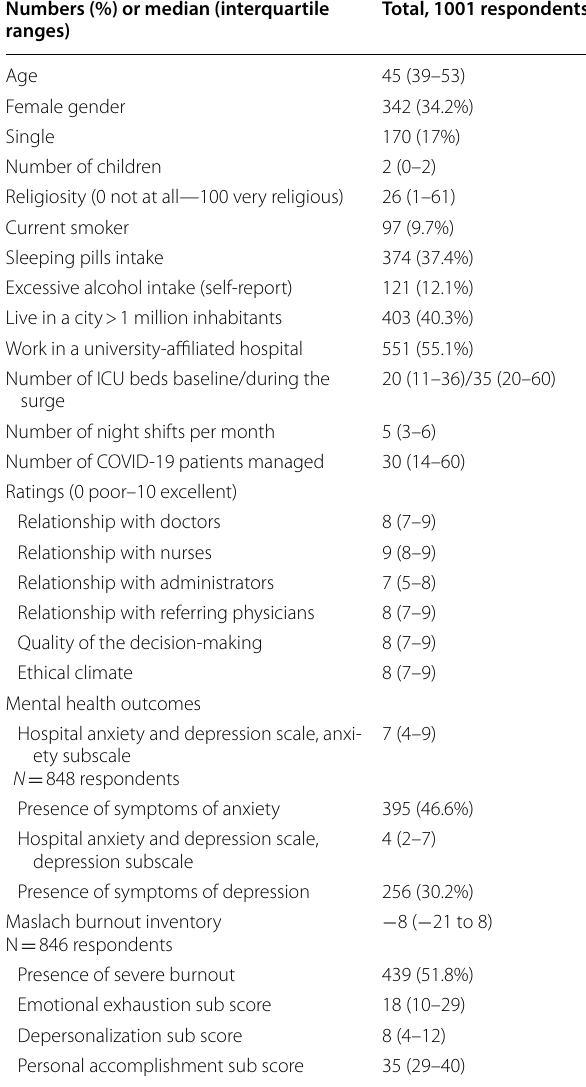
Fig. 2 Physician’s ranking (from 0 [very poor relationship] to 10 [excellent relationship]) of their relationship with other ICU specialists, nurses, administrators, or with referring physicians. They have also ranked the quality of the decision-making and the ethical climate in their ICU. Results are presented according to the presence of symptoms of anxiety ( a ), the presence of symptoms of depression ( b ), or the presence of symptoms of severe burnout ( c ). This figure displays the results in the 848 ICU specialists returning complete HADS. *** indicates P value <